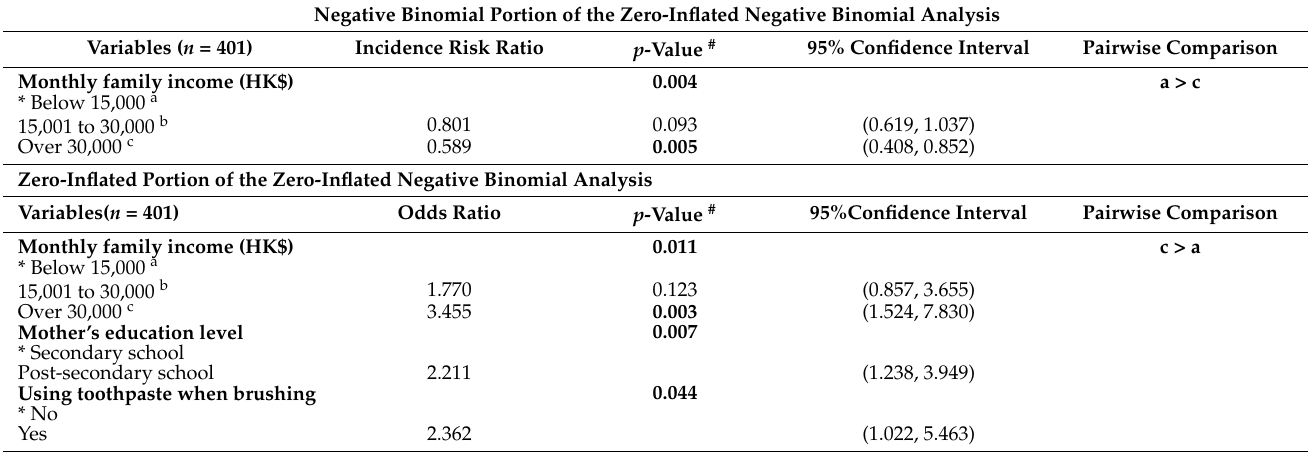
# Bold figure: p -value < 0.05; * Reference